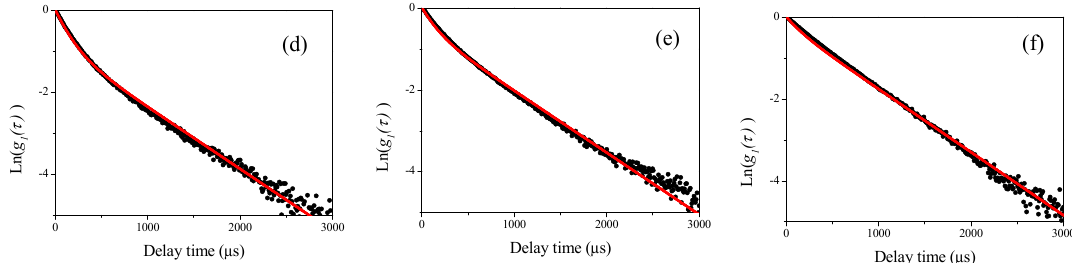
Figure 8. Observed homodyne photon correlation functions (black dots) vs. calculated homodyne photon correlation function curve using equations 1 and 2 (red solid curves) for the results shown in Figure 6c,d. ( a ) 70-350-1 at a detector angle of 120°; ( b ) 70-350-2 at a detector angle of 120°; ( c ) 70-350-3 at a detector angle of 120°; ( d ) 70-350-1 at a detector angle of 150°; ( e ) 70-350-2 at a detector angle of 150°; and ( f ) 70-350-3 at a detector angle of 150°.